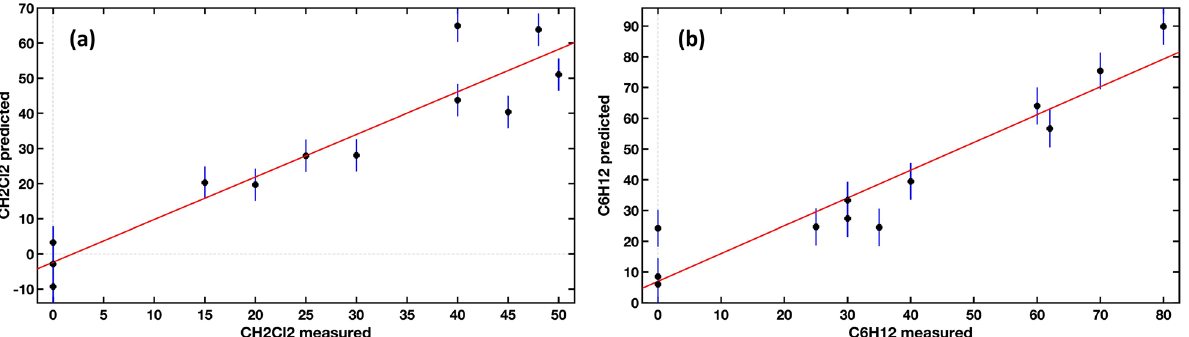
Figure 8. Predicted and measured concentrations with prediction model error bars for CH 2 Cl 2 ( a ) and C6H12 ( b ). Units in ppm.